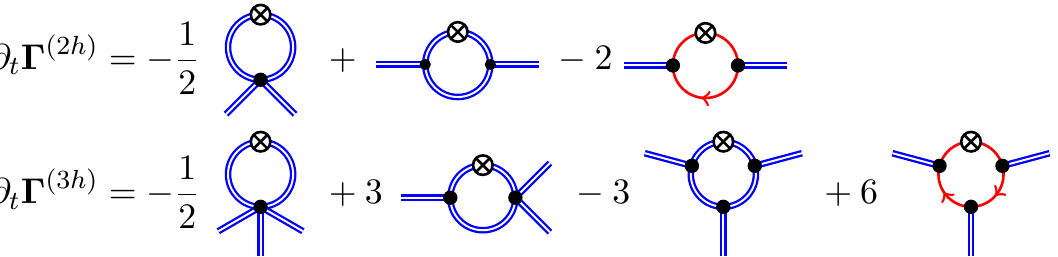
Figure 2: Diagrammatic representation of the flows of the fluctuation graviton two- and three-point functions, from which we extract the flow of the fluctuation graviton propagator and the flow of the physical Newton coupling, respectively. The latter relates to the flow of the background graviton propagator. Double blue lines represent graviton propagators, red single lines ghost propagators, and the cross stands for a regulator